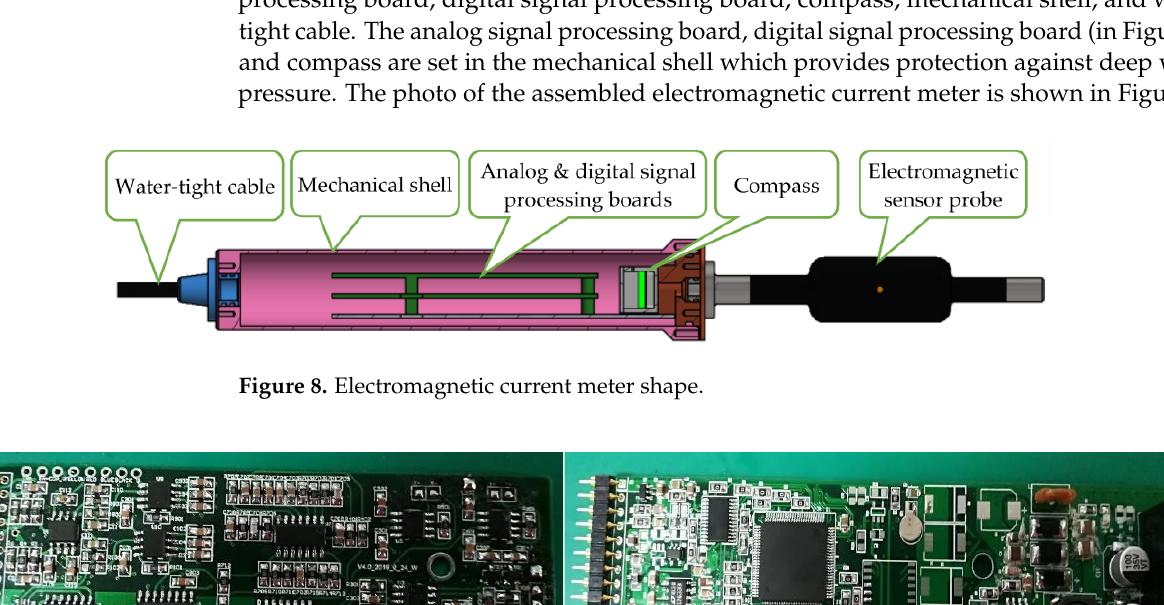
Figure 7. Flow chart of electromagnetic current measurement.